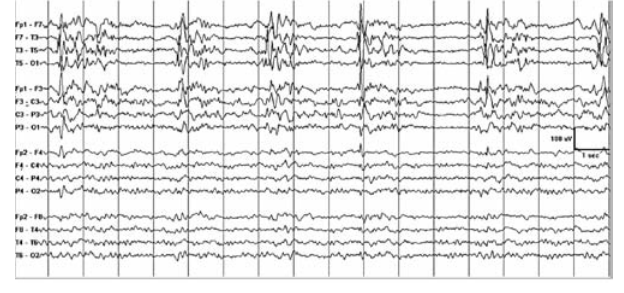
Figure 1. Electroencephalogram of Patient A showing left-sided burst suppression 45 minutes after status epilepticus termination with fosphenytoin 1000 mg, lorazepam 4 mg, and propofol 2 mg/kg load. The occasional right-sided sharp waves that stand out against the low-amplitude slow background activity are most likely the result of volume conduction from the left hemisphere source. Unihemispheric burst suppression persisted as propofol was being infused at 2 mg/kg/hr and disappeared 4 hours later when the infusion rate was 5 mg/kg/hr. Propofol was discontin- ued after 12 hours with no recurrence of seizure activity and uni- hemispheric burst suppression.